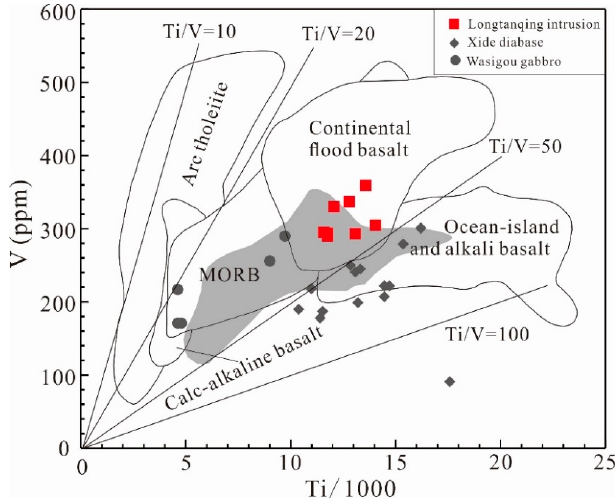
Figure 12. V–Ti discrimination diagram of [120] for the basic rocks from Longtanqing, Xide, and Wasigou, western YZB. The shaded areas outline the ranges of compositions for basic-ultrabasic rocks from the Hannan Massif of the northwestern YZB with data source from [45].